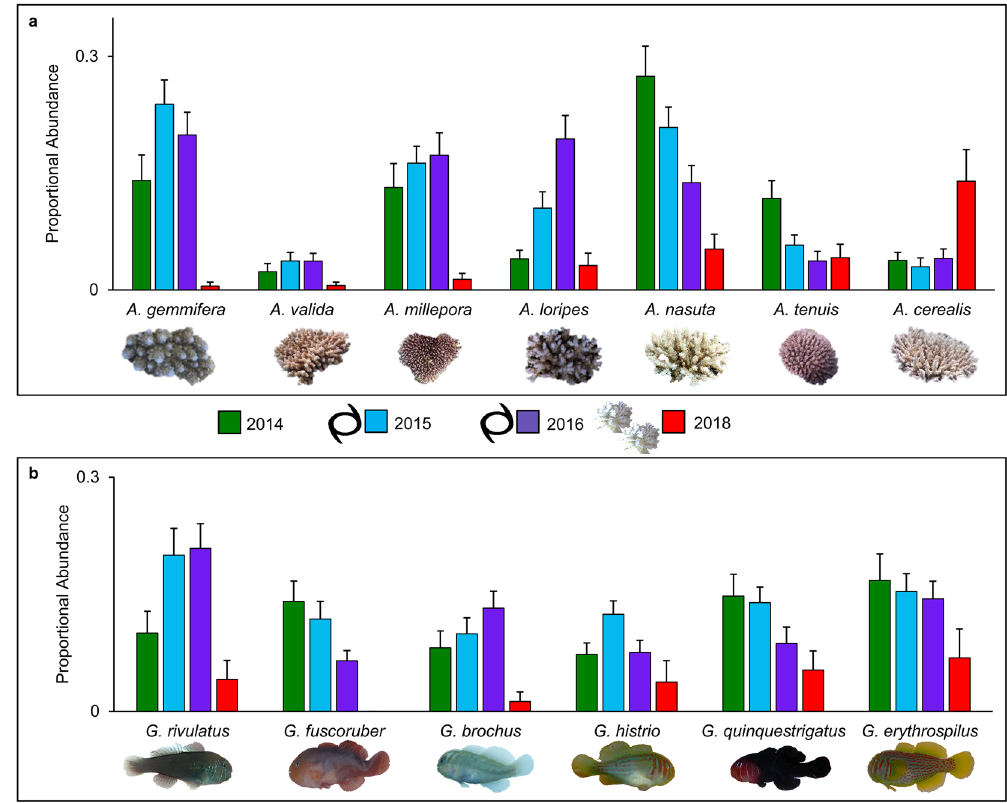
Figure 4. Changes in abundance of coral and goby species before and after each consecutive climate disturbances. The proportional abundances for the most common species within each transect (n = 279) for ( a ) Acropora corals and ( b ) Gobiodon gobies is shown before and after each disturbance around Lizard Island, Great Barrier Reef, Australia: effect of each cyclone (black cyclone symbols) and combined effect of two consecutive heatwaves/bleaching events (white coral symbols). Proportional abundances were calculated by taking the count per species per transect divided by the total count among all species observed per transect. Visualized here are the proportional abundances pooled per sampling event for the most common species. Figures were illustrated in Microsoft Office PowerPoint